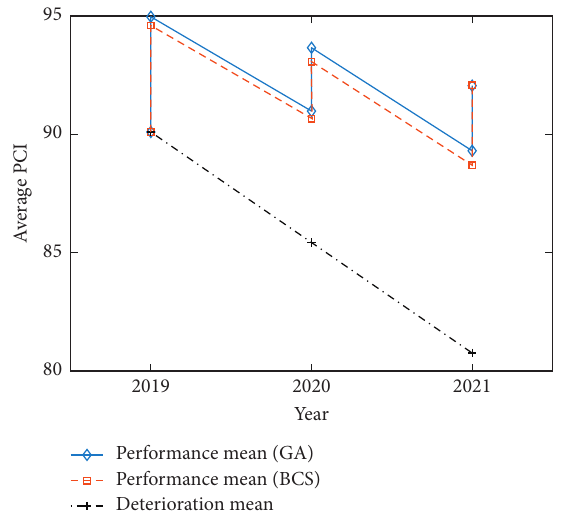
Figure 8: Pavement performance under M&R cost minimization.